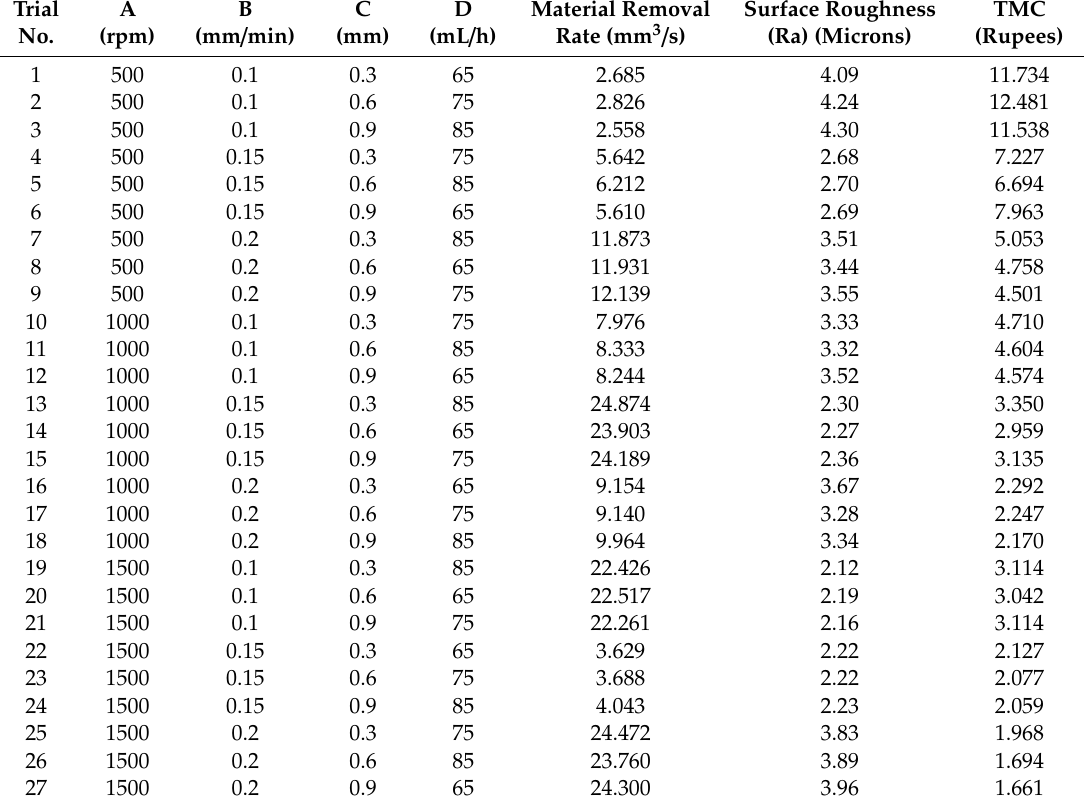
Table 4. Experimental layout with